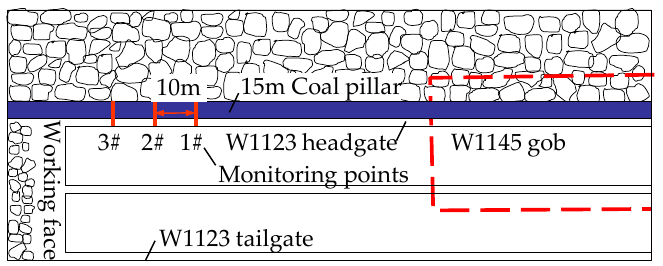
Figure 17. Roadway stability monitoring.